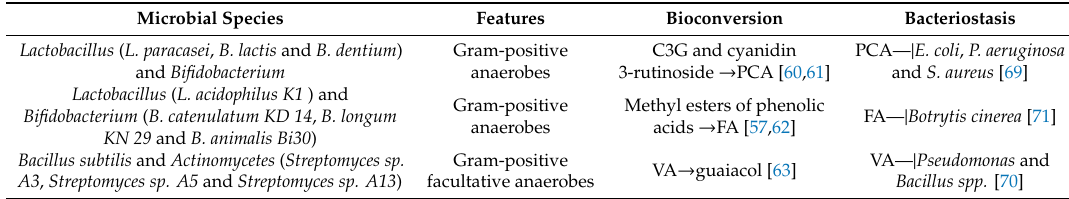
Table 2. Crosstalk between C3G&C3G-Ms and microorganism.